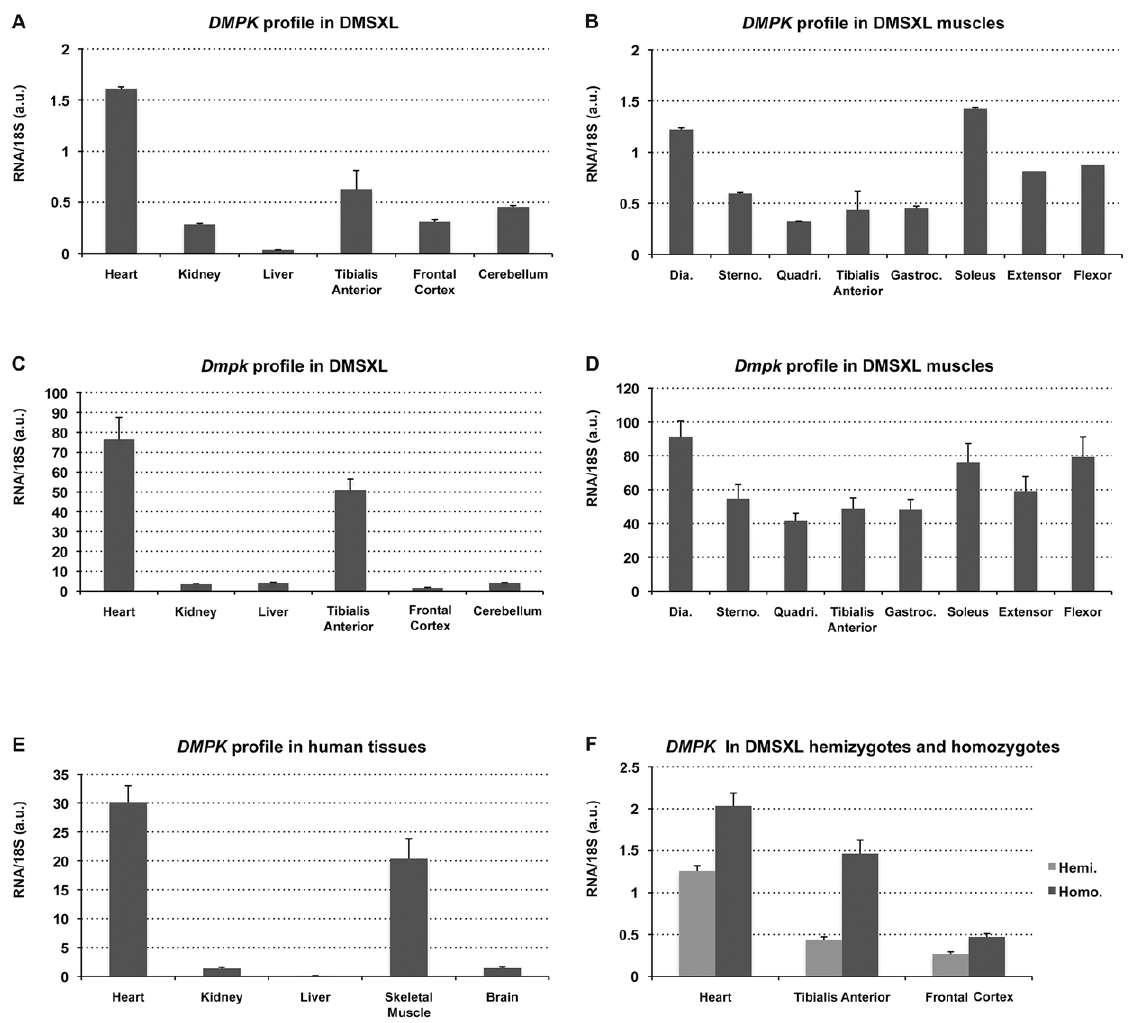
Figure 2. DMPK expression profiles. Expression of the human DMPK transgene was studied in various hemizygous DMSXL tissues (A) and muscles (B), in parallel with the endogenous Dmpk mouse gene (C and D) (n=3). (E) Expression of DMPK in human tissues. Dia., Diaphragm; Sterno., Sternomastoid; Quadri, Quadriceps; TA, Tibialis Anterior; Gastroc. Gastrocnemius. (a.u.): arbitrary units. (F) Expression of DMPK in hemizygous (Hemi.) and homozygous (Homo.) DMSXL tissues. Data are presented as means 6 standard deviation.